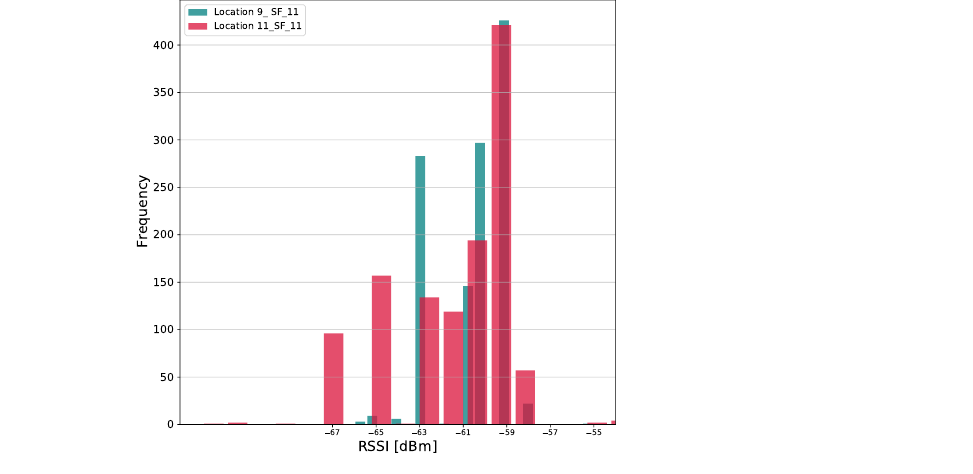
Figure 17. Histogram of RSSI values from gateway zero for ROOM A509 for location points 9 and